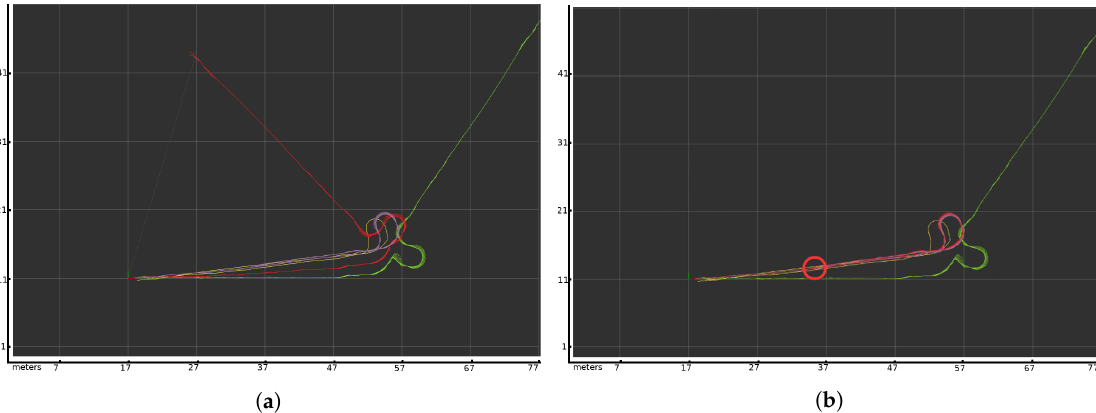
Figure 4. Change in wheelchair’s position in the corridor. The grid represents a resolution of 10 m. The green line corresponds to the position reported by the odometry sensor. The purplr line is the position reported by the laser scan matcher, and the red one shows the result of fusing the odometry, IMU with static covariance and laser scan matcher with variable covariance. The yellow line represents the ground truth displacement according to the Velodyne sensor. ( a ) Test where static odometric covariance takes precedence over variable laser scan matching covariance in a corridor with a turn. ( b ) Variable laser scan matching covariance takes precedence over static odometric covariance in the same scenario. The red circle marks the final